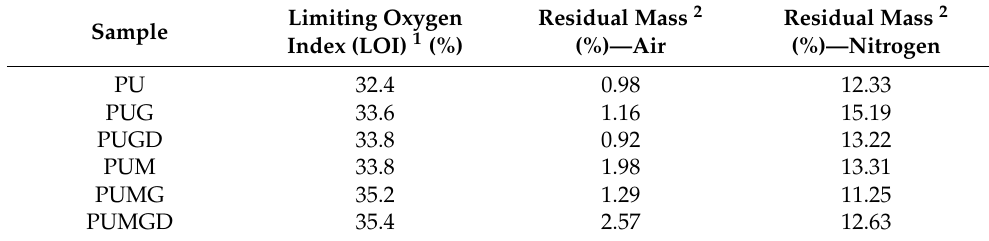
Table 7. Flammability tests for polyurea nanocomposite